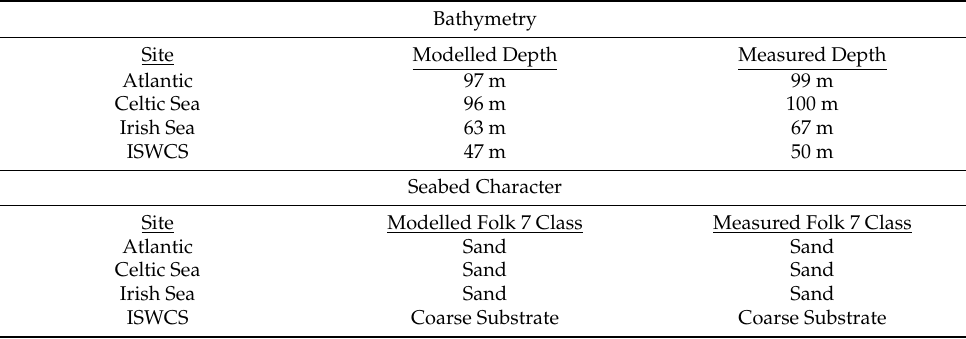
Table 12. Results of bathymetry and seabed character model